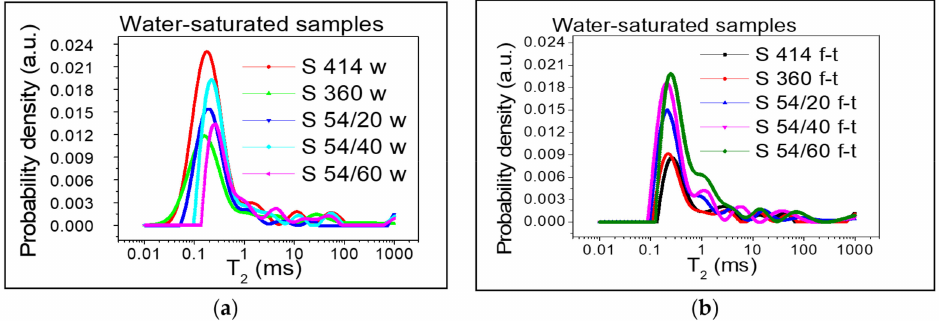
Figure 5. Distribution of the transverse relaxation time T 2 after water saturation: ( a ) control samples kept in water (w); ( b ) samples subjected to 300 freeze–thaw cycles